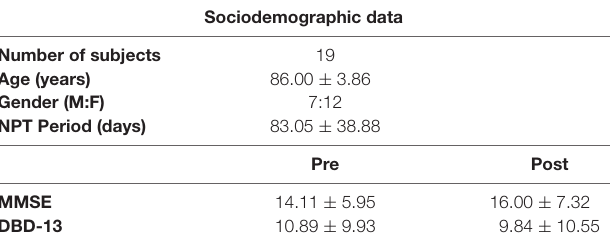
FIGURE 1 | Schematic overview of the time course of the study. Two assessments took place during the study: at the beginning and the end of the therapy. Each assessment consisted of MEG recording and application of Mini-Mental State Examination (MMSE) and Dementia Behavior Disturbance (DBD)-13 tests, that were performed within 3 days. The period between assessments is defined as the time between the first and the second assessments. The non-pharmacological treatment (NPT) period is defined as the time between the admission in the facility and the second assessment. TABLE 1 | Sociodemographic and clinical information of the